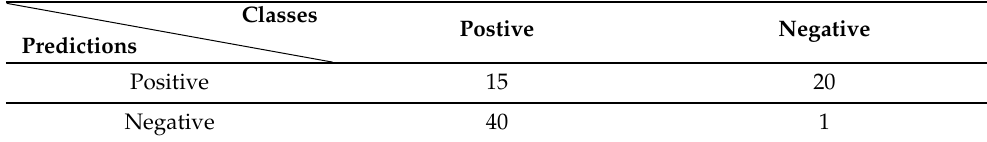
Table 4. Confusion matrix A.